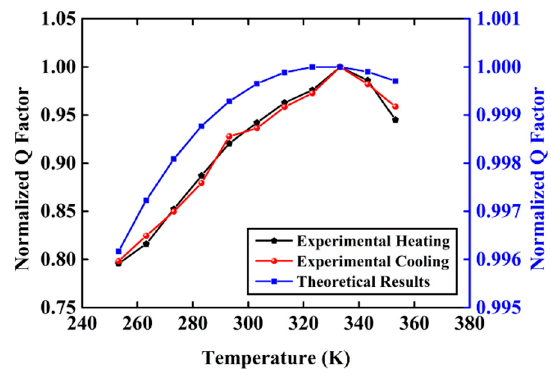
Figure8. ThemeasuredandtheoreticalnormalizedQfactorvaryingwithtemperatureatthetemperature Figure 8. The measured and theoretical normalized Q factor varying with temperature at the range from 253.15 K to 353.15 temperature range from 253.15 K to 353.15 K.